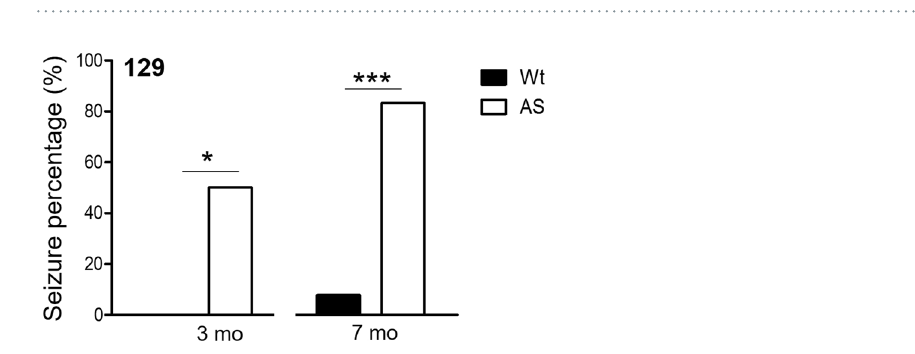
Figure 5. Analysis of spontaneous epileptiform activity. ( a ) Representative traces of spontaneous polyspike burst activity were identified in AS mice of all three background strains. The B6 and F1 hybrid AS mice typically exhibited more pronounced and frequent polyspike events compared with 129 AS mice. The Wt mice of all backgrounds did not show abnormal EEG activity. ( b ) Quantification of polyspike activity in all three strains during continuous vEEG recording (24 hrs for 5 days). Both B6 and F1 AS mice exhibited more polyspike events in cortical and hippocampal EEG traces compared with 129 AS mice. The B6 AS mice showed the most pronounced and frequent polyspikes. For each strain, AS and Wt mice were compared with a Student’s t-test with Welch’s correction where variances were significantly different and data are shown as the mean ± SEM; n = 3–7 mice/group; * p < 0.05. CTX: cortex, HC: hippocampus.